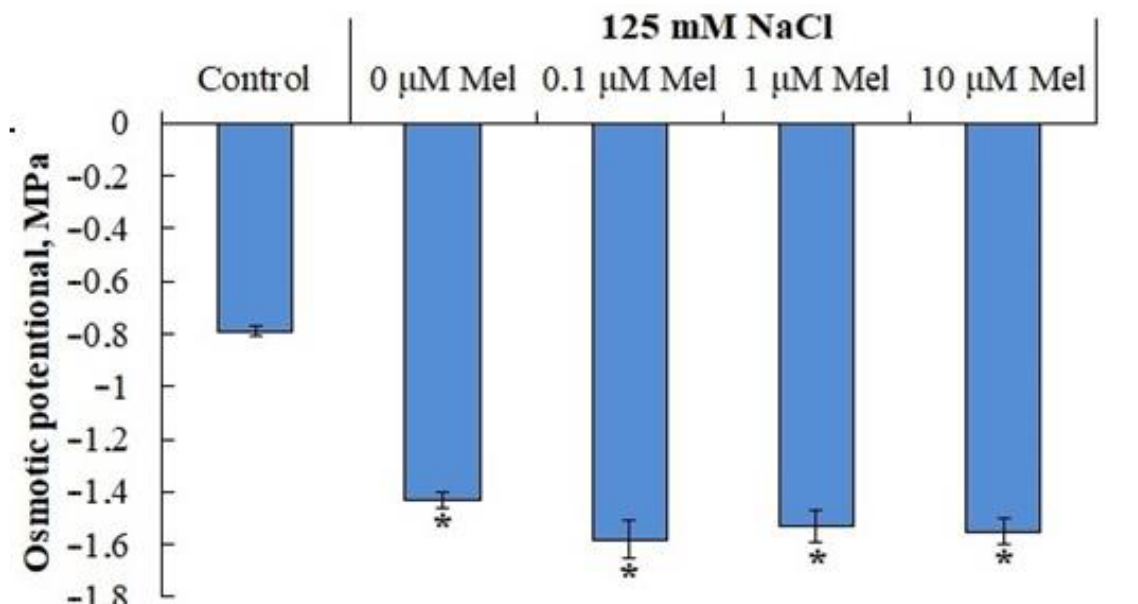
Figure 4. Influence of melatonin and chloride salinity on the value of the osmotic potential of the cellular exudate of Solanum tuberosum leaves. Asterisks (*) indicate significant differences from the control variant ( p < 0.05).